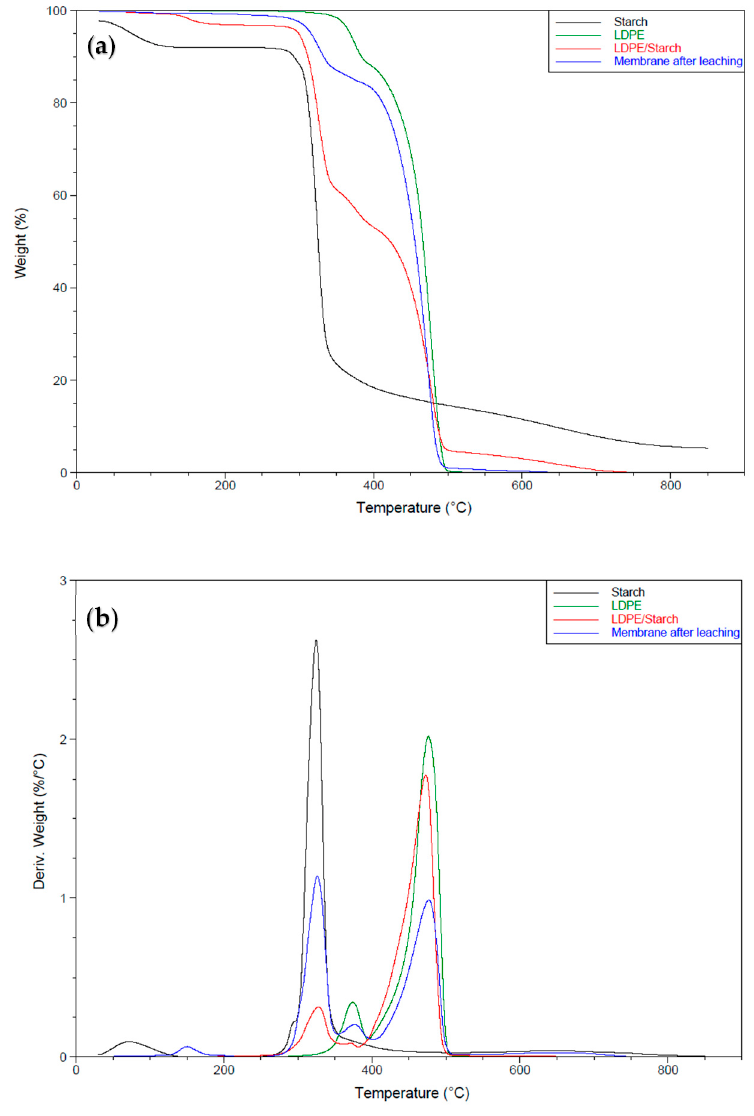
Figure 9. ( a ) Thermogravimetric analysis curves of LDPE, CS, and the membrane under N 2 and ( b ) first derivative of the curves presented in ( a ). Table 2. TGA results for CS, LDPE and the membrane.